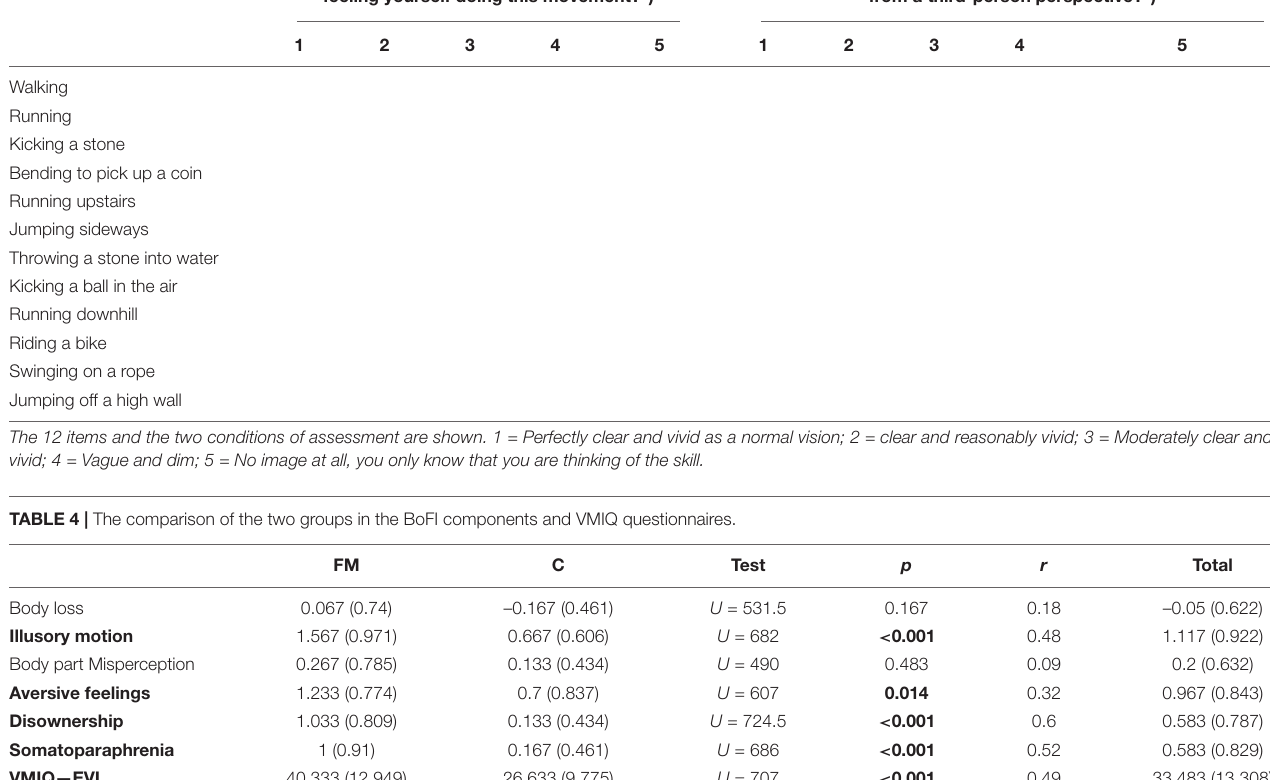
TABLE 3 | The Visual Motor Imagery Questionnaire (Roberts et al., 2008). Kineasthetic (“how well can you imagine feeling yourself doing this movement?”)